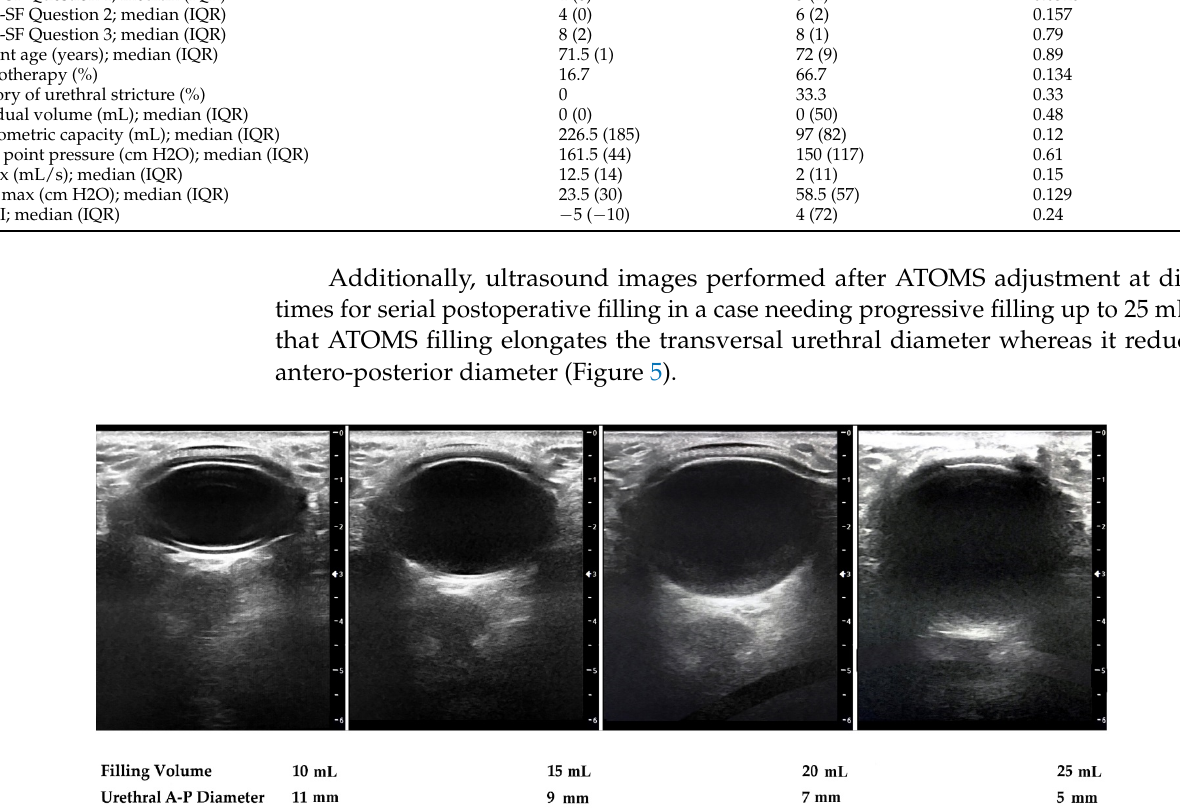
Table 2. Cluster characterization according to features expressed; significant values in bold.